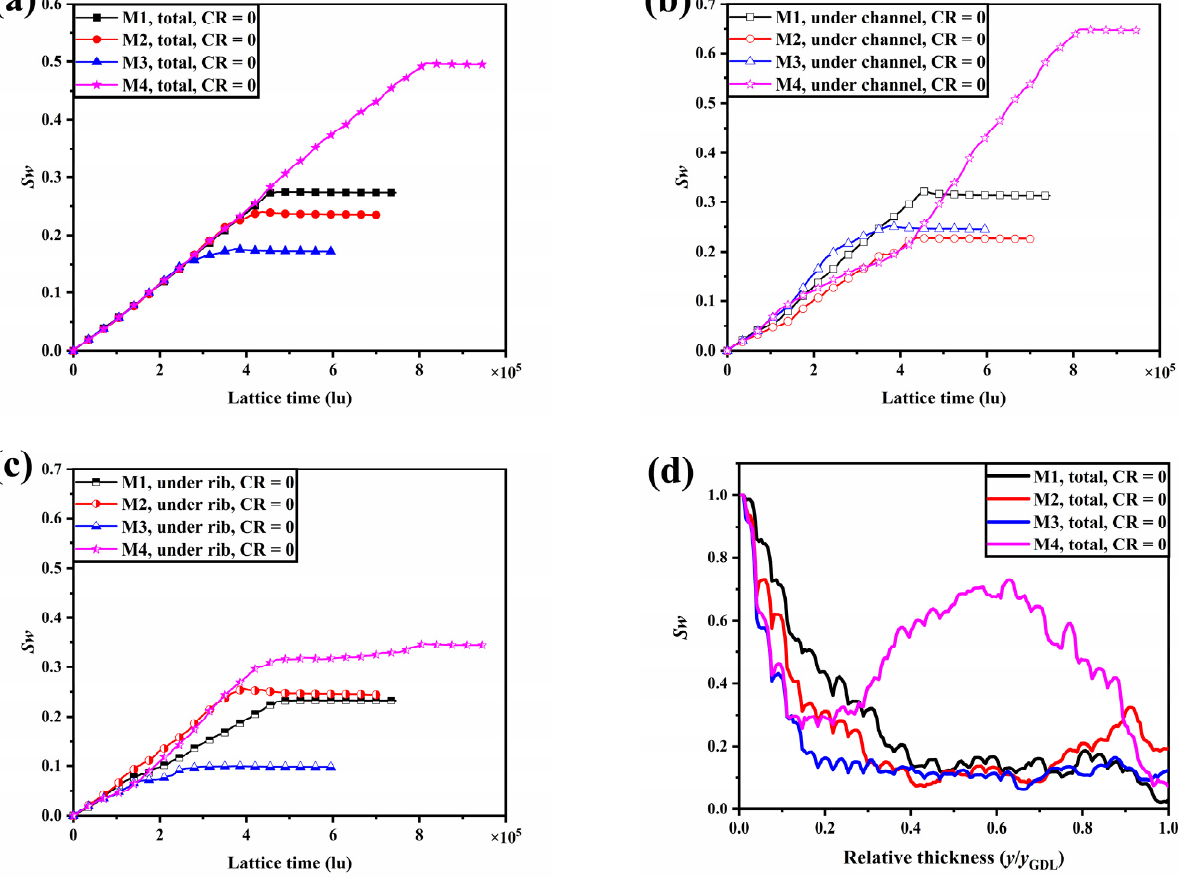
Figure 4. ( a ) The evolution of the total liquid water saturation within the GDL over time; the varia- tion of liquid water saturation within the GDL under the channel ( b ) and under the rib ( c ) with time; ( d ) the distribution of water saturation along the through-plane direction as liquid water reaches the steady state within M1, M2, M3, and M4.